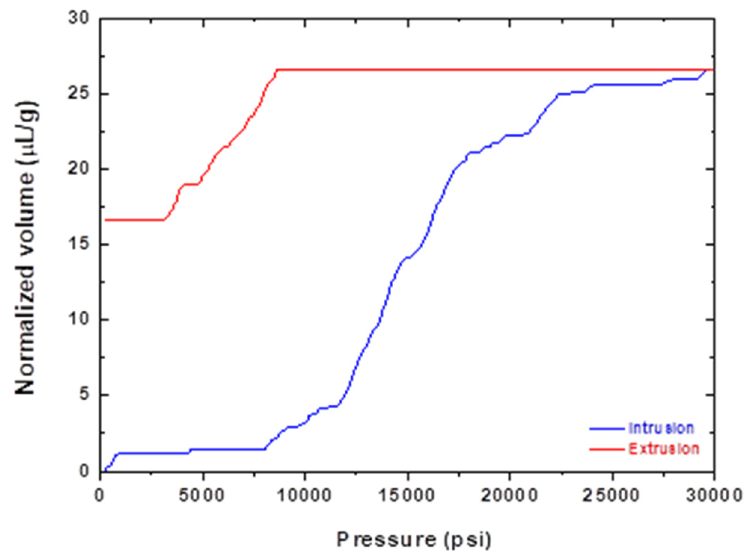
Figure 8. Mercury intrusion porosimetry results.